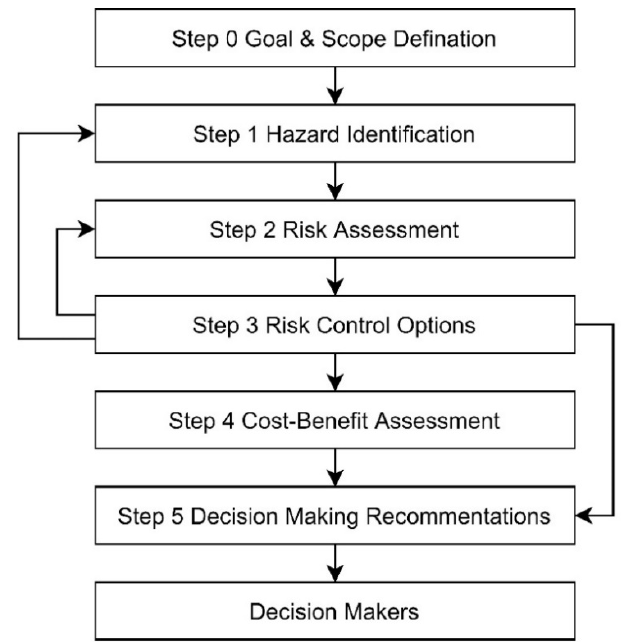
Figure 1. General approach of a formal safety assessment (FSA) [21].